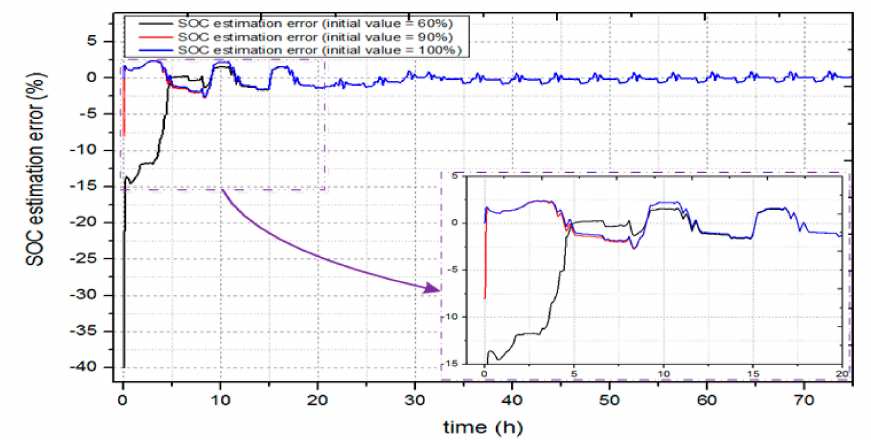
Figure 11. SOC estimation error with different initial values.